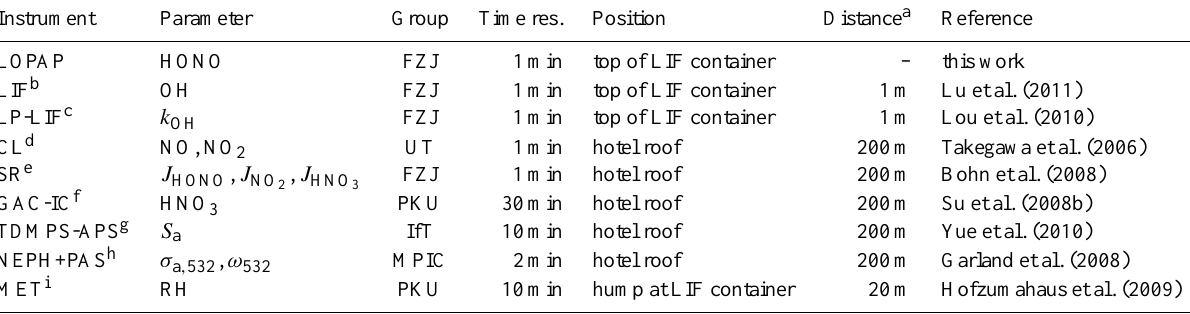
Table 1. Instrumentation at the Guangzhou backgarden supersite. The instruments listed here do only refer to data used in this study. For a comprehensive overview of all instruments participating see Hofzumahaus et al. (2009); Lou et al. (2010); Lu et al. (2011); the measured parameters are explained in the